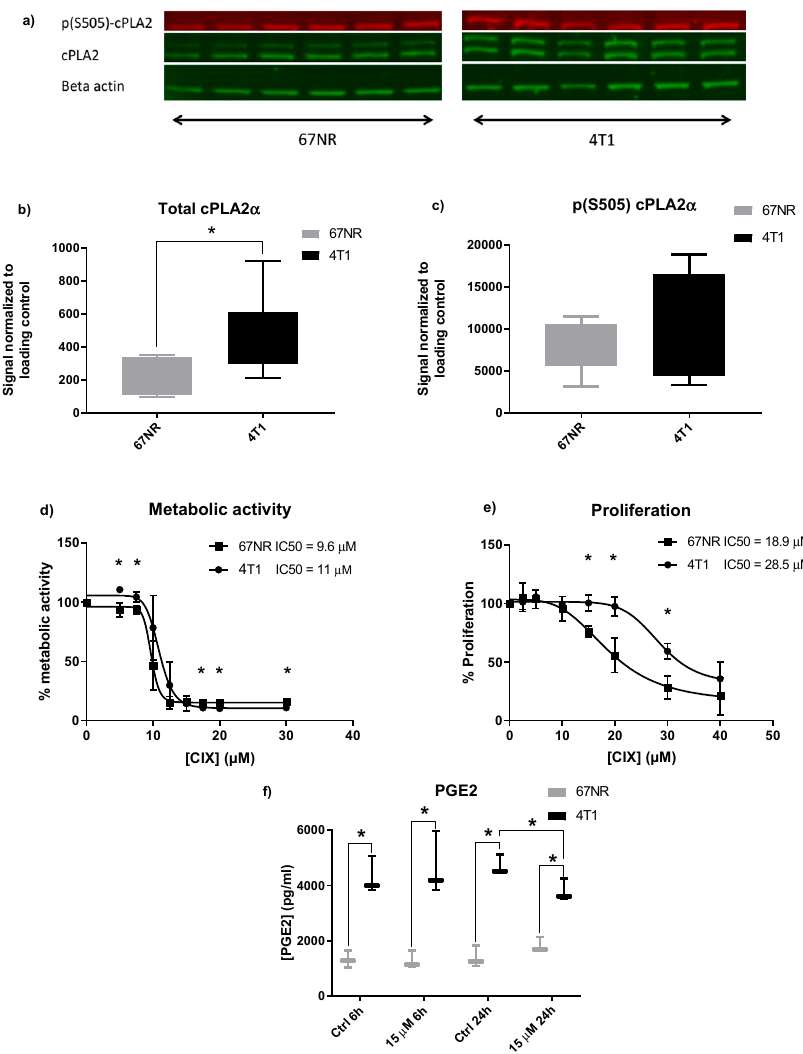
Figure 1. Response to cytosolic phospholipase A2 α (cPLA2 α ) inhibitor X (CIX) and expression of cPLA2 α in 67NR and 4T1. ( a ) Image showing bands for basal p-cPLA2 α , cPLA2 α , and beta-actin expression in 67NR and 4T1 cells on the same membrane. ( b ) Box and whisker plots (min-max) of total cPLA α protein normalized to beta-actin. ( c ) Box and whisker plots (min-max) of phosphorylated cPLA α (p-S505) protein normalized to beta-actin. ( d ) Viability curve based on XTT (2,3-bis-(2-methoxy-4-nitro-5-sulfophenyl)-2H-tetrazolium-5-carboxanilide) metabolization. Points represent grand mean of n = 3 experiments with n = 6 technical replicates per condition. IC50 values (48 h) are given in µ M. * p < 0.05 4T1 vs. 67NR at the same concentration. ( e ) Proliferation curve based on EdU incorporation. Points represent grand mean of n = 3 experiments with n = 6 technical replicates per condition. IC50 values (24 h) are given in µ M. * p < 0.05 4T1 vs. 67NR at same concentration. ( f ) PGE2 levels in 67NR and 4T1 at 6 h and 24 h of treatment. The box and whisker plot (min-max) is based on n = 3 experiments with n = 3 technical replicates per condition. * p < 0.05 4T1 vs.